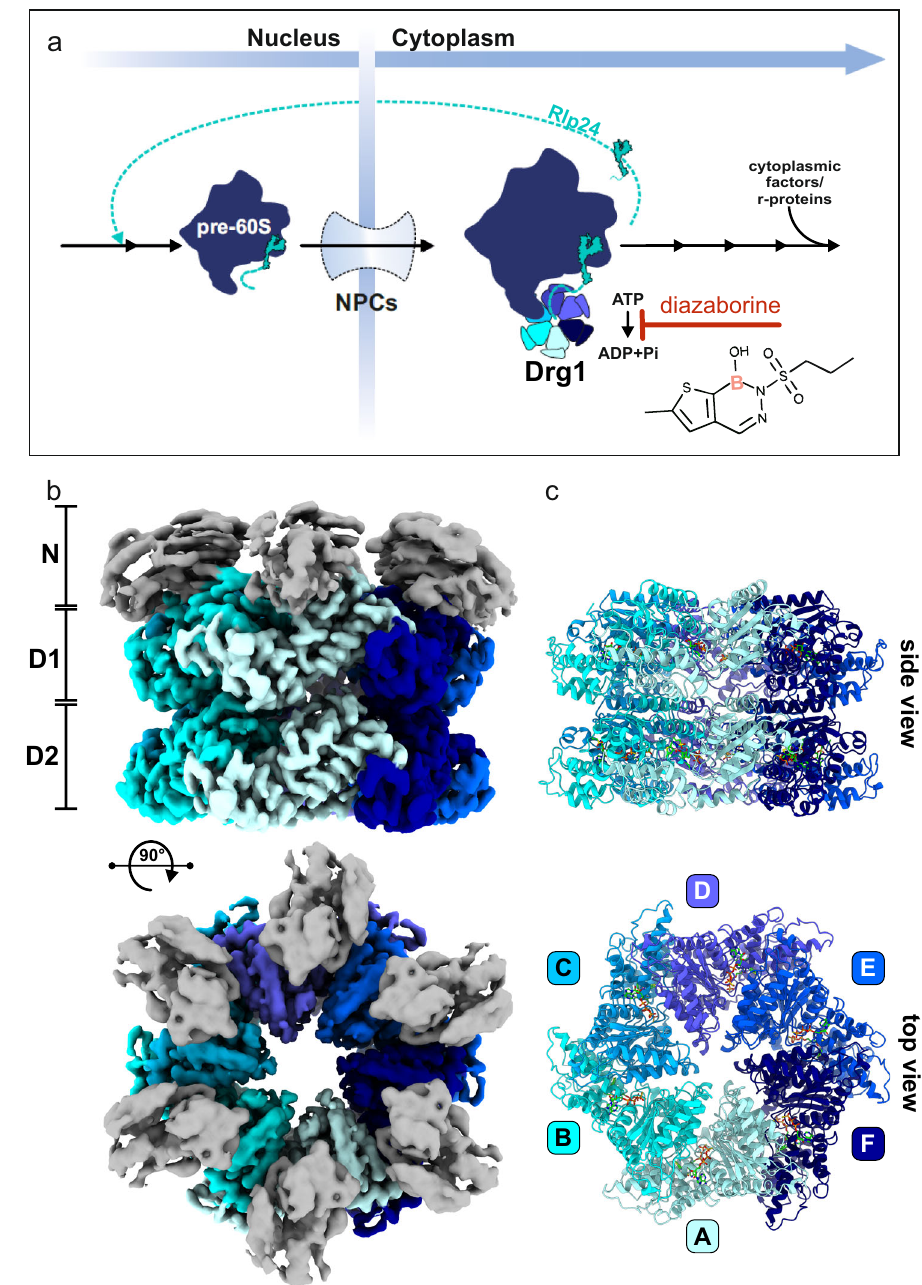
Fig. 1 Cryo-EM structure of the AAA-ATPase Drg1 in complex with diazaborine. a Diazaborine inhibits the AAA-ATPase Drg1 and thereby blocks the release of Rlp24 which is the fi rst cytoplasmic maturation event of the large ribosomal subunit (60S). b 3.4 Å cryo-EM map of a diazaborine bound Drg1 hexamer in top and side view. The D1 and D2 AAA-domains of the six monomers are symmetrically arranged around the open central pore re fl ecting a substrate-free, inactive state of the AAA-ATPase. The N-domains are less well resolved due to their intrinsic fl exibility which re fl ects the nucleotide- binding state of the D1 nucleotide-binding pocket. c The atomic model comprises amino acids 239 – 780 of each of the six monomers (A – F) fully covering both AAA-domains but lacking the